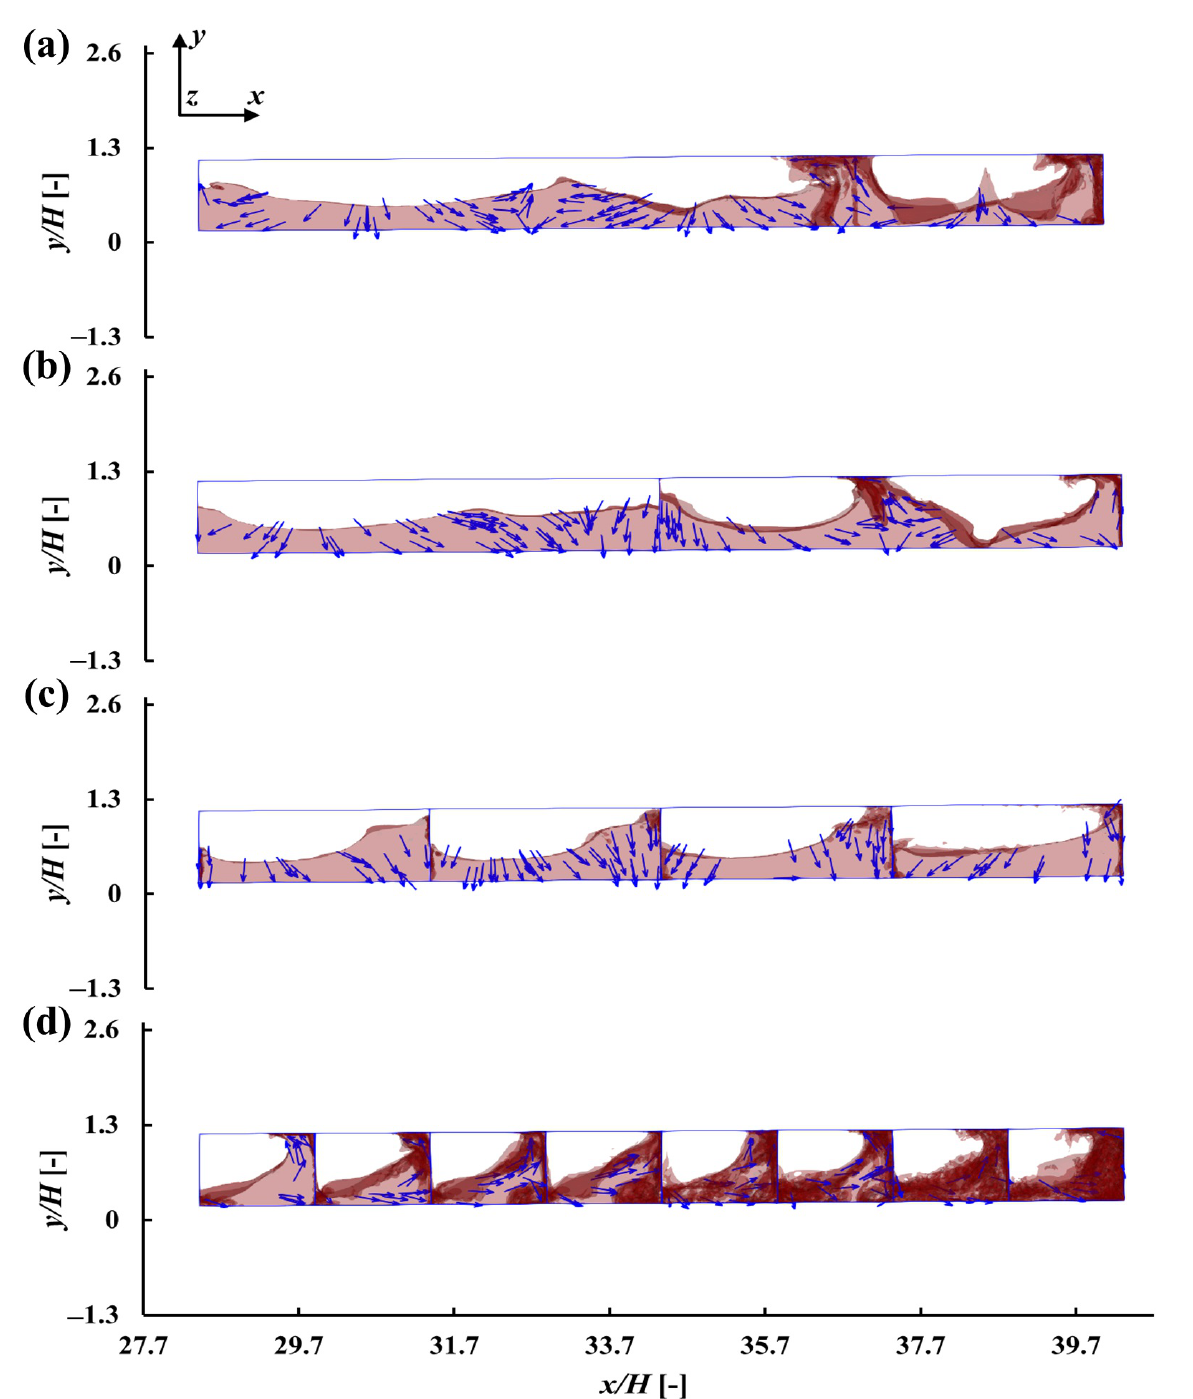
Figure 15. Snapshots for the sloshing tank with D i = 0.25 at t / T = 5.5 for ( a ) N c = 1, ( b ) N c = 2, ( c ) N c = 4 and ( d ) N c = 8. Water phase is shown as transparent red with dark red representing the free surface. Blue arrows show the general direction of motion of the sloshing